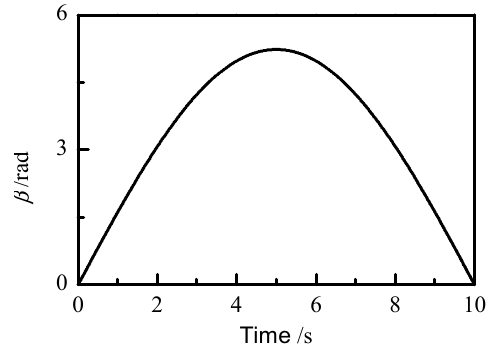
Figure 15. Pitch angle input.